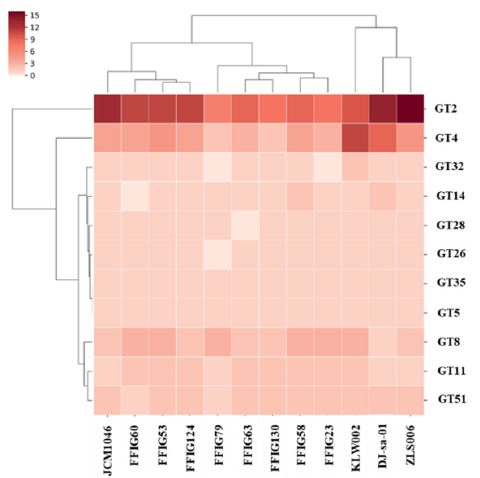
Figure 5. Genomic comparison of the glycosyltransferases present in the genomes of Ligilactobacillus salivarius strains isolated from the intestinal mucosa of wakame-fed pigs and other L. salivarius strains of porcine origin with available public genomes. The heat-map was constructed considering the numbers of glycosyltransferases in each family.